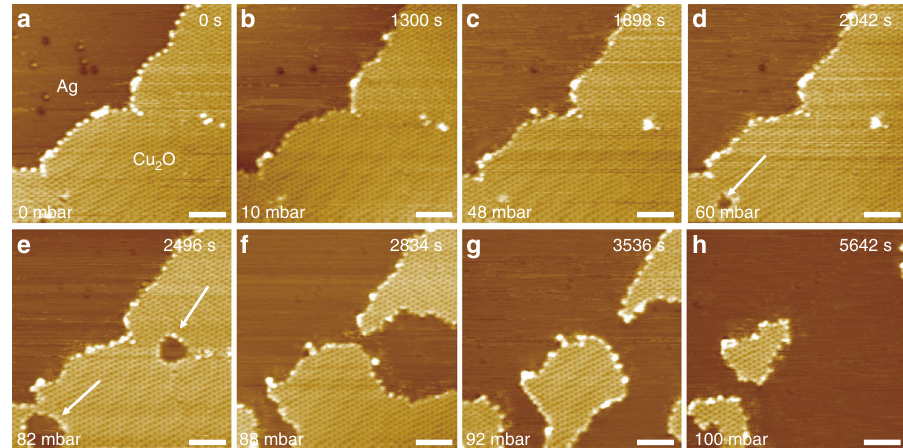
Fig. 4 Reaction of CO on Cu 2 O/Ag(111). a – h In situ NAP-STM images on the reduction of the Cu 2 O/Ag(111) surface under elevated CO pressures from 0 to 100 mbar at 300 K. Reduction of the Cu 2 O layer was observed in >48 mbar CO, starting from domain boundaries indicated by white arrows in d , e . The pressures of CO were labeled at the bottom left of STM images, and reaction times were labeled at the top right of images. Scanning parameters: a – h V s = 0.9 V, I = 0.1 nA. Scale bars: 5 nm for